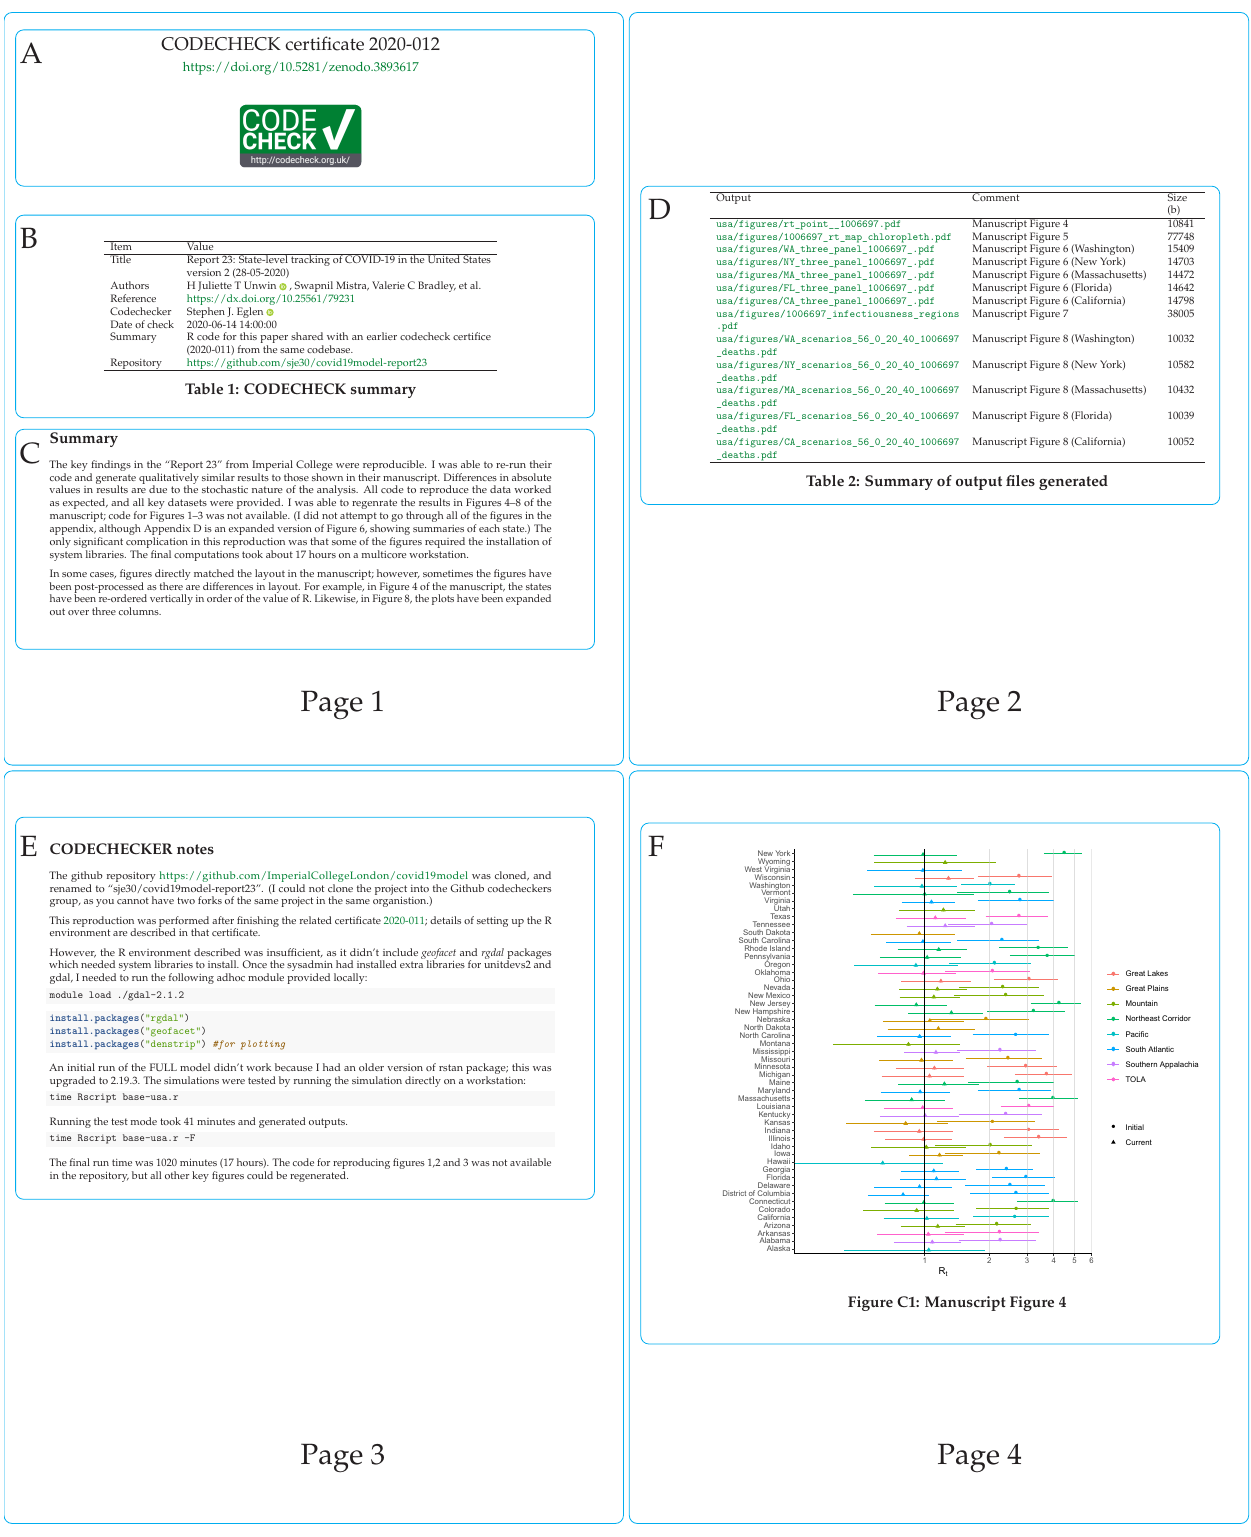
Figure 4. Annotated certificate 2020–012 51 (first four pages only).